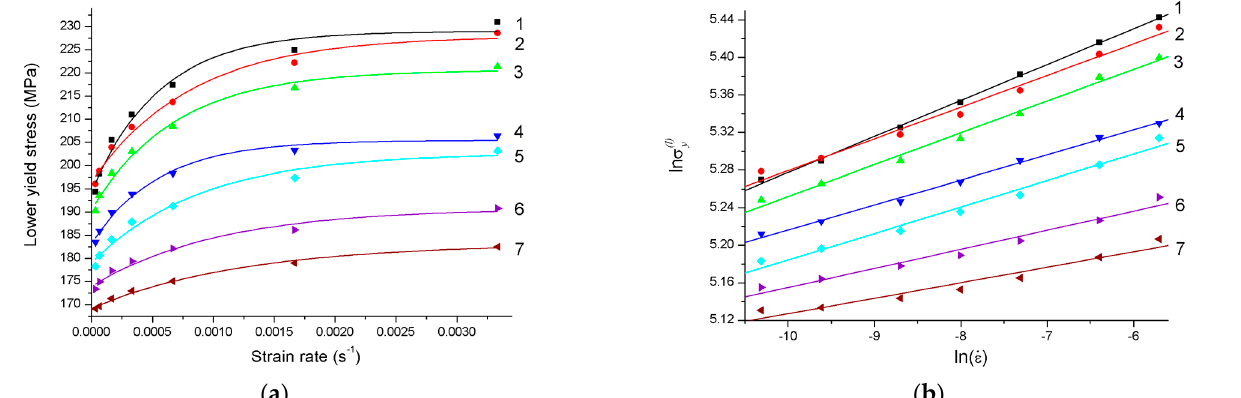
Figure 2. Rate dependences of lower yield stress at 296 (1), 313 (2), 323 (3), 333 (4), 343 (5), 373 (6), and 393 K (7) (a); the same in logarithmic coordinates (b).